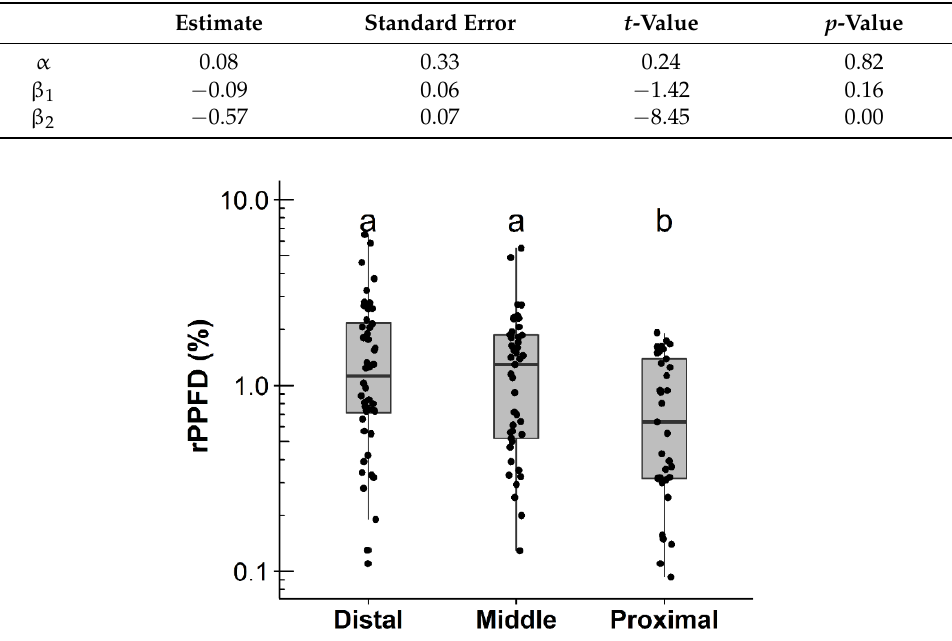
Table 4. The effect of secondary branch positions on the relative photosynthetic photon flux density ln(rPPFD) for secondary branches selected in 2015. The estimates correspond with the mean ln(rPPFD)s at the Distal, Middle, and Proximal parts, where α corresponds to the estimates of the Distal, α + β 1 to the Middle, and α + β 2 to the Proximal parts. The data of rPPFD (%) (the response variable) were transformed into natural logarithm to meet the assumption of normal residuals ( n = 126).